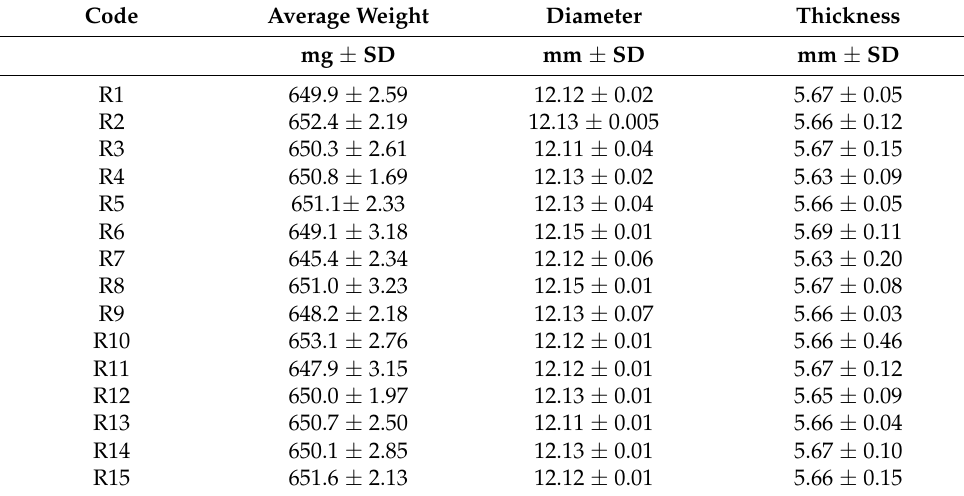
Table 1. Average weight, thickness and diameter of the formulated tablets.